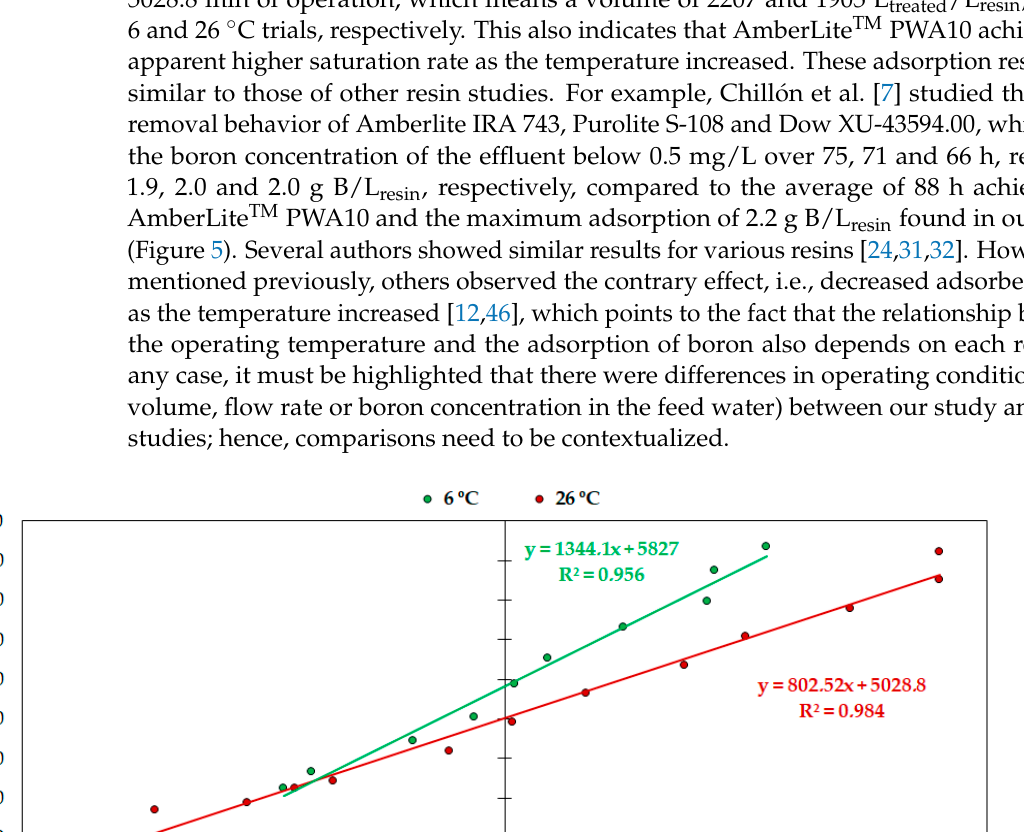
− [ B ])) at 6 and 26 ◦ feed water ]